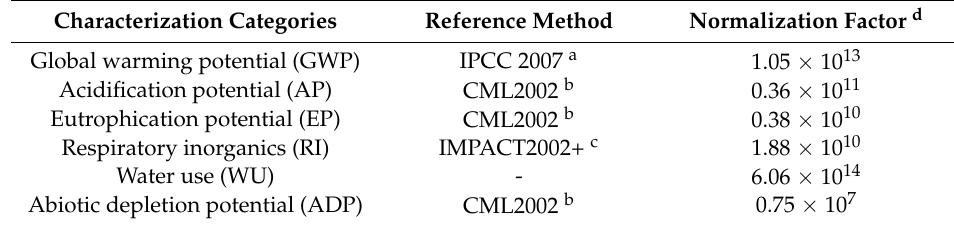
Table 1. The reference methods of characterization categories and the values of normalization factors in this